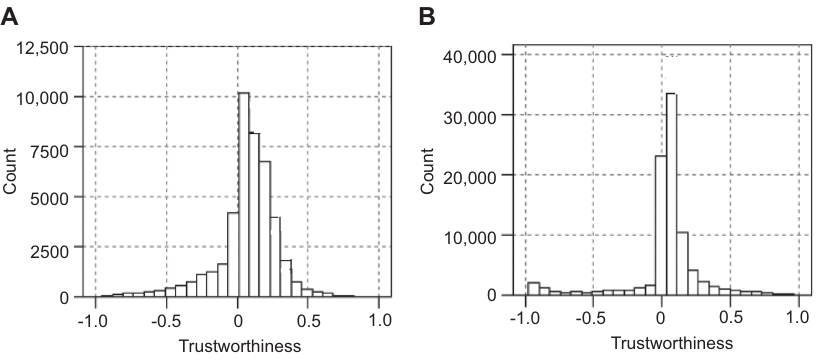
Figure 4. Distribution of Trustworthiness Values. (A) Dataset for Slashdot, (B) Dataset for